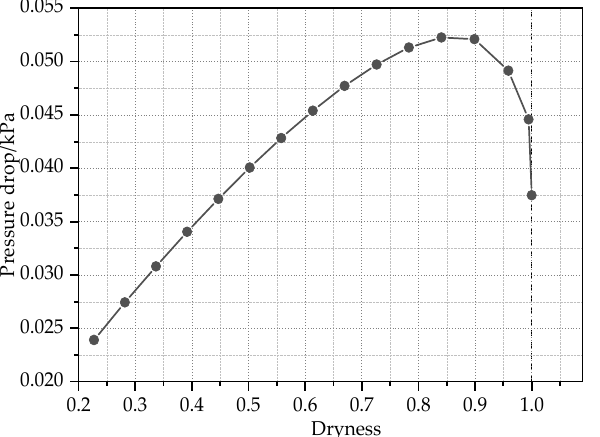
Figure 10. Refrigerant pressure drop changing with the dryness in the two-phase region of the 1st microchannel.